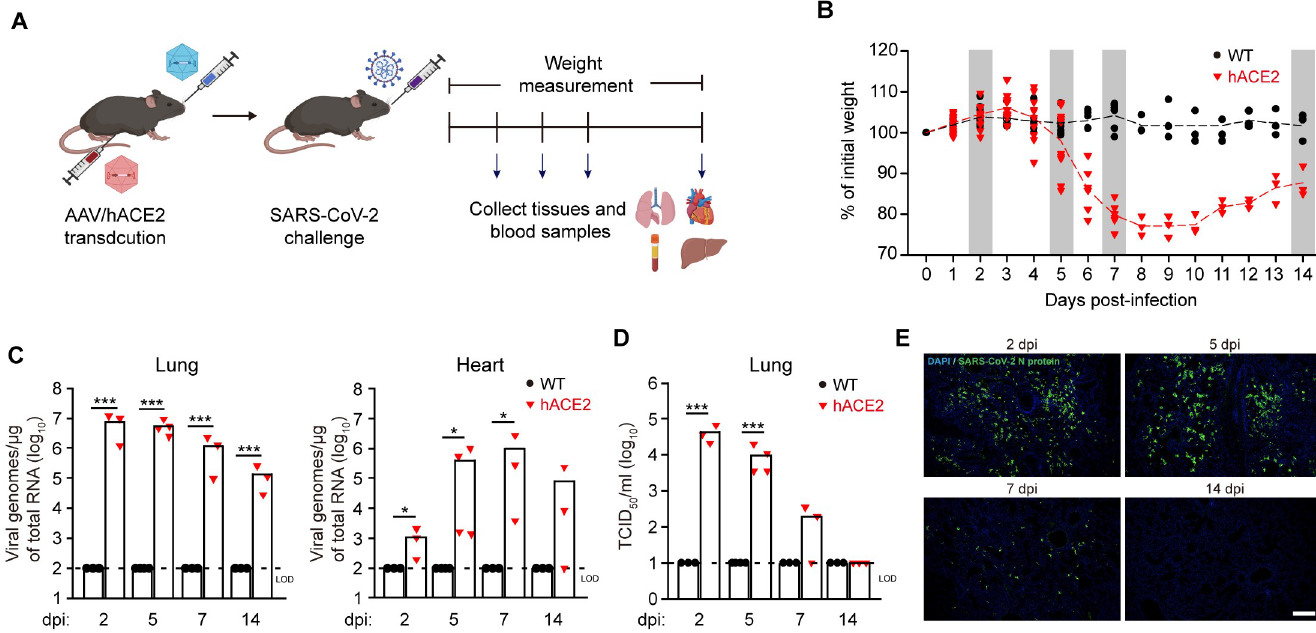
Fig 3. SARS-CoV-2 infection and body weight changes in AAV/hACE2 mice. (A) The experimental procedure of SARS-CoV-2 infection in AAV/hACE2 mice. (B) The weight changes of non-transduced wild-type (WT, black circle) and AAV/hACE2 (red triangle) mice challenged with SARS-CoV-2 at different days post-infection (dpi) (n = 13 at 0–2 dpi, n = 9 at 3–5 dpi, n = 6 at 6–7 dpi, and n = 3 at 8–14 dpi). Gray bars indicate the dates when lungs and blood samples are collected for further analyses. (C and D) The numbers of viral genomic RNA (C) and infectious virion (D) in the lung and heart of WT (black circle) and AAV/hACE2 (red triangle) mice at 2, 5, 7, and 14 dpi. Dashed lines indicate the limit of detection (LOD, 10 2 viral genomes/ μ g of total RNA for subfigure c and 10 1 TCID50/ml for subfigure d). Bars indicate mean values. P values were calculated by two-tailed unpaired Student’s t test ( � , P < 0.05; �� , P < 0.005; ��� , P < 0.0005). (E) The lungs of infected AAV/ hACE2 mice were collected at 2, 5, 7, 14 dpi, and the viral N proteins were detected by immunofluorescence staining (blue, DAPI; green, SARS-CoV-2 N protein). Scale bar, 200 μ m.